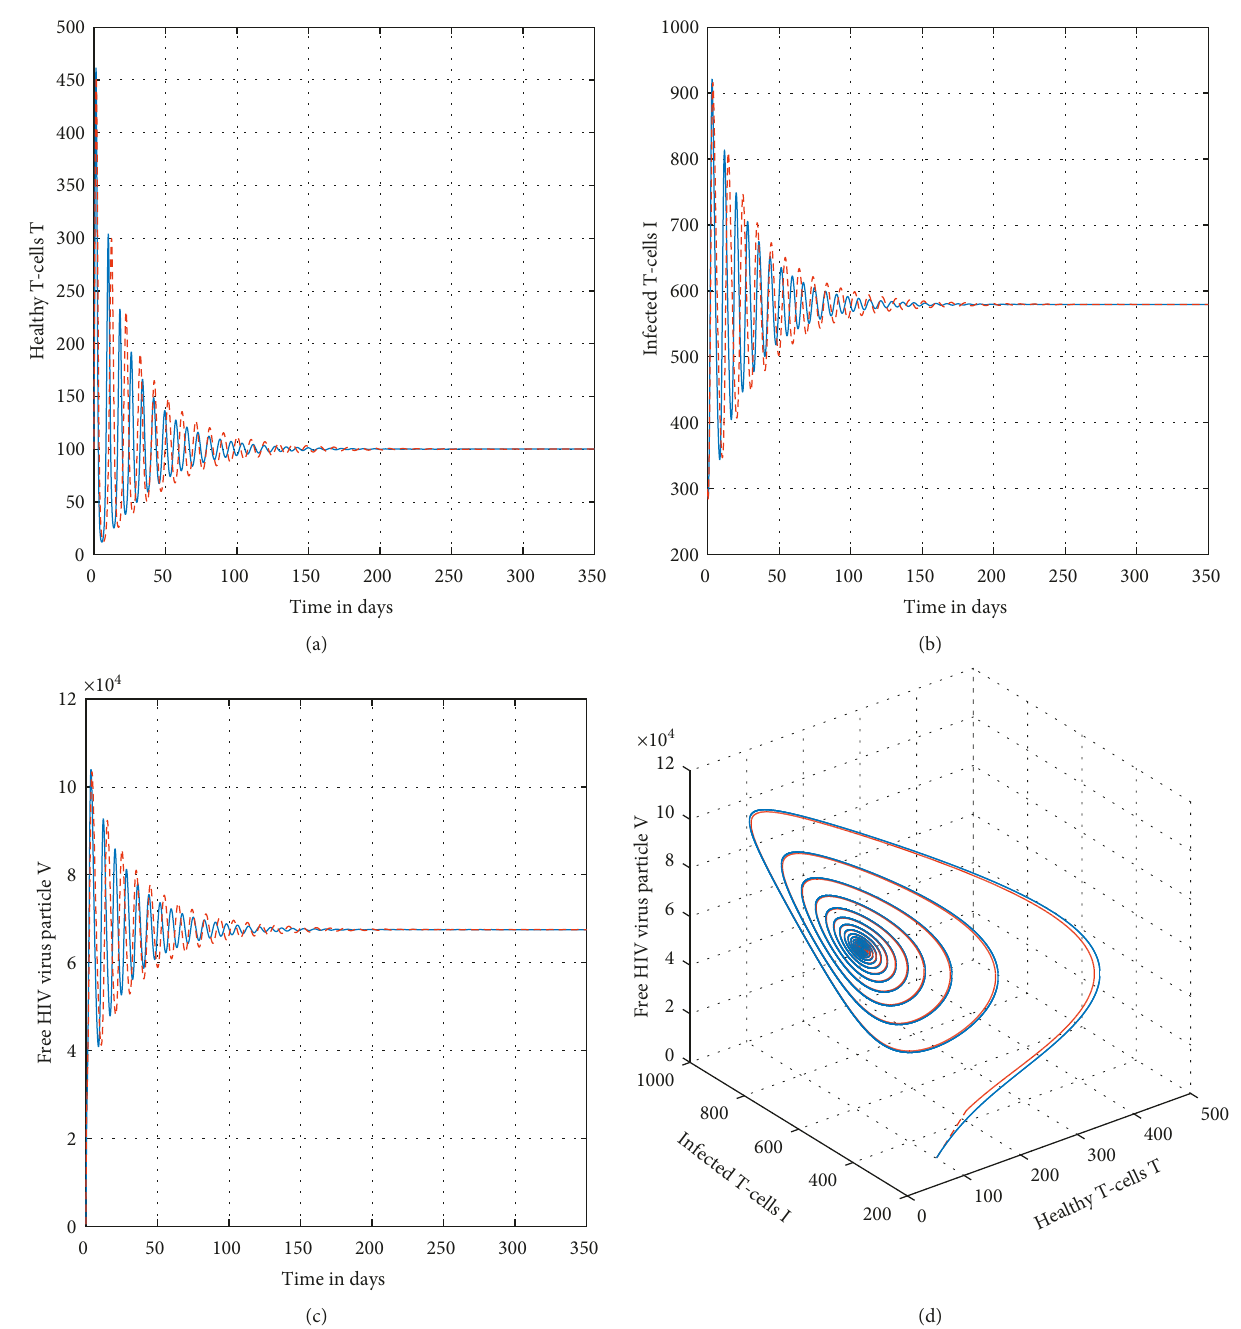
Figure 3: Graphical view analysis of the fractional model (2) of HIV by taking the index of memory ϑ � 0 .